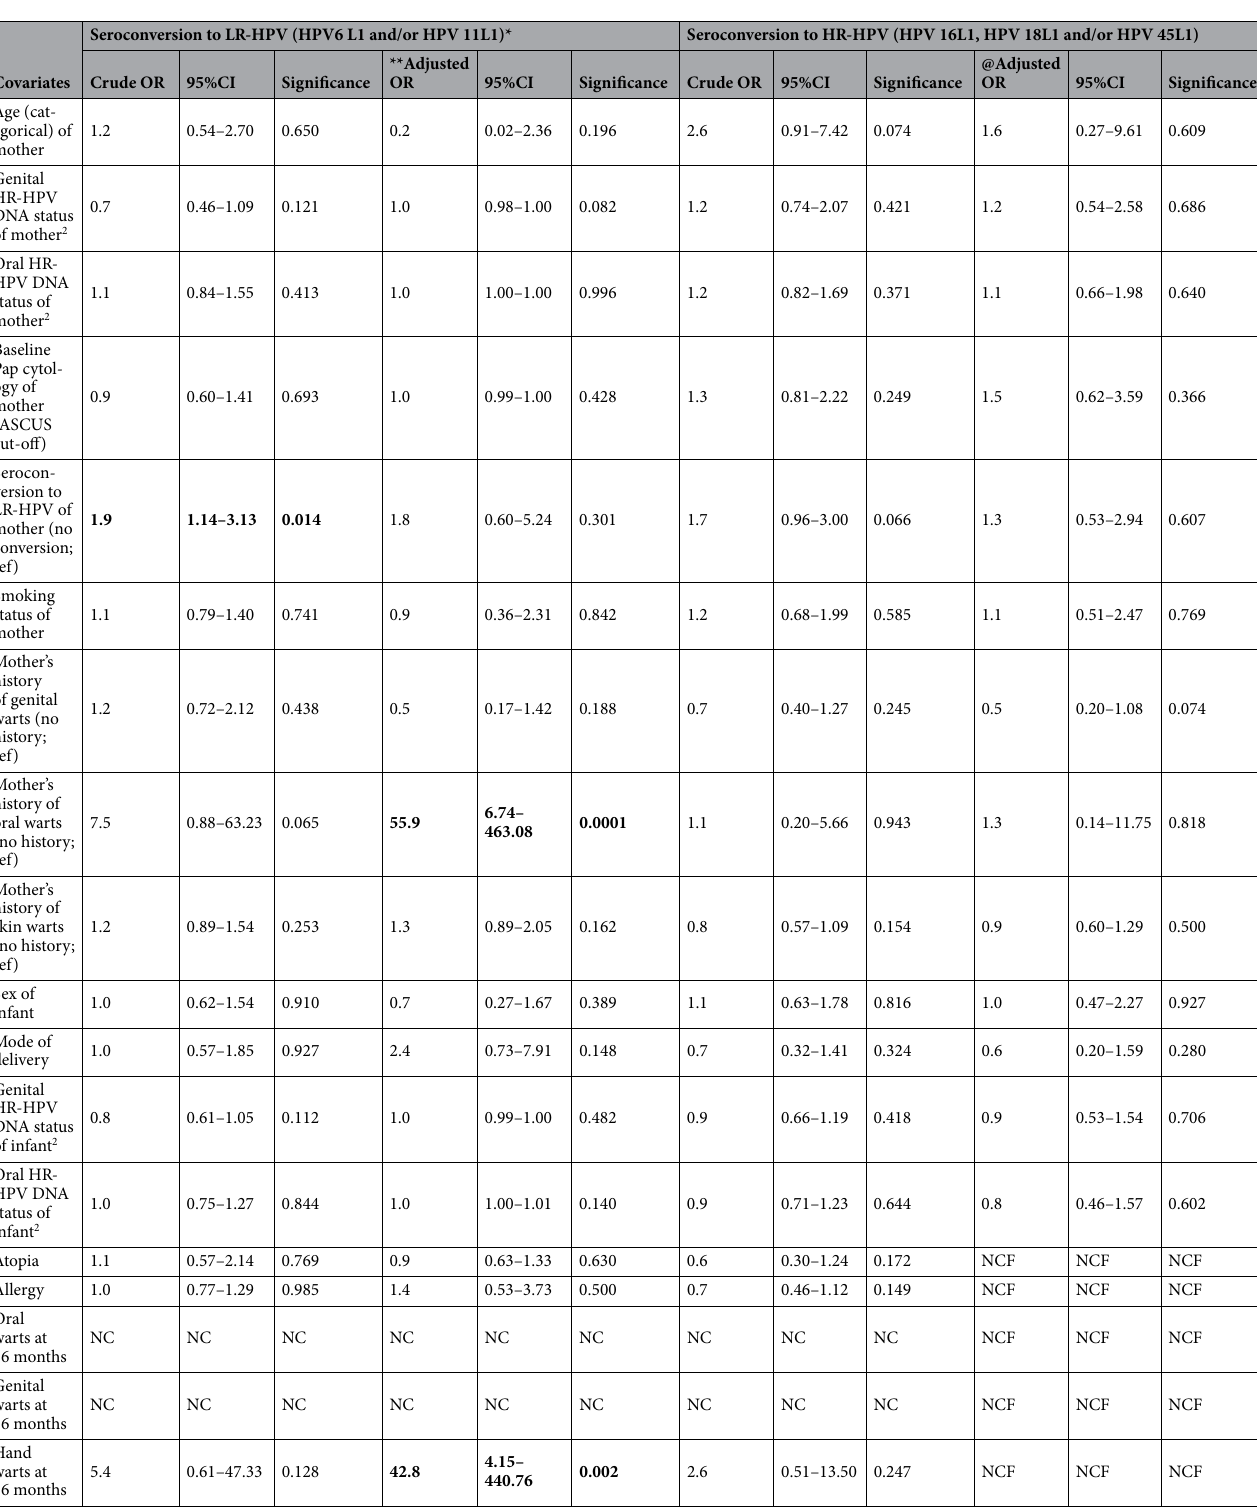
Table 3. Predictors of seroconversion of the infants to LR-HPV (HPV 6, 11) and HR-HPV (HPV 16, 18, 45) L1 antigens during the follow-up in time-dependent GEE modelling 1 run in univariate model and as adjusted for other covariates. Statistically significant values are marked as bolded. *Binary outcome (Conversion/ No conversion) detected during the 36-mo follow-up (Cut-off 200 MFI, and > 2 × increase of Ab titers in two subsequent samples); 1 Results obtained from time-dependent GEE with logit link for binary outcomes clustered by child ID number; **adjusted for all other covariates in the model; 2 High-Risk (HR)-HPV detected at any follow-up (FU) visit; OR, odds ratio; CI, confidence interval; NC, not computable, no relevant cases; NCF, not computable due to failure to achieve